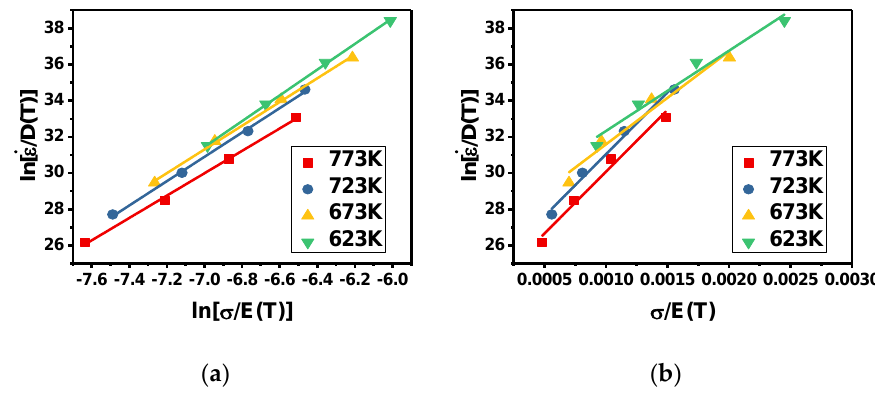
Figure 3. Relationships between material parameters: ( a ) ln[𝜀̇ 𝐷(𝑇)⁄ ] against ln[𝜎 𝐸(𝑇)⁄ ] ; ( b ) ln[𝜀̇ 𝐷(𝑇)⁄ ] against 𝜎 𝐸 ( 𝑇 )⁄ .